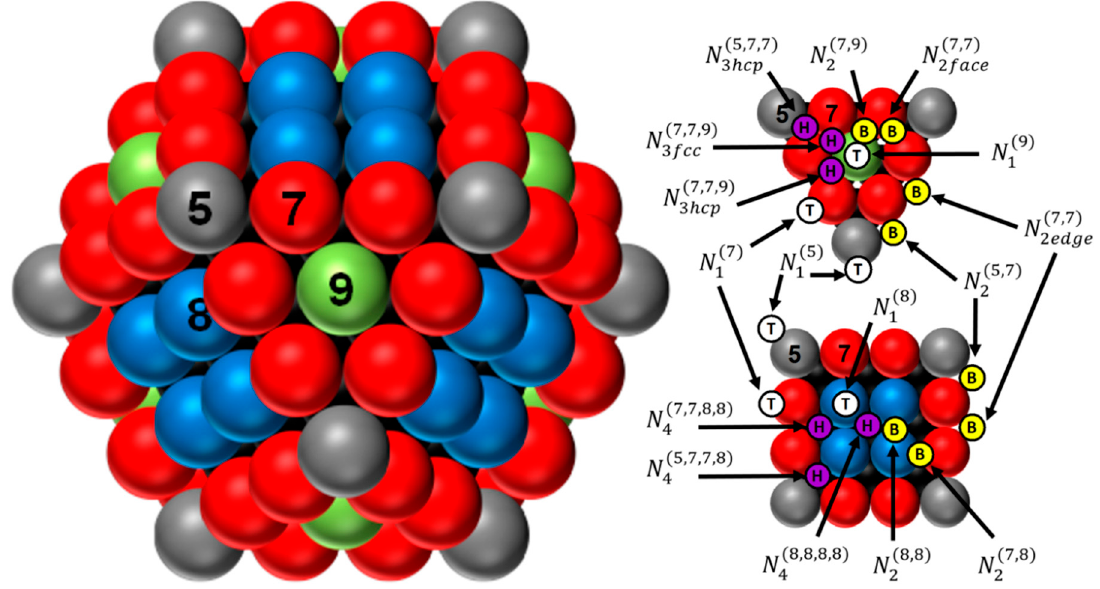
Figure 1. Representation of the perfect cuboctahedron (with m = 4) and its adsorption sites over triangular and square faces. The numbers 5 (grey), 7 (red), 8 (blue), and 9 (green) represent the coordination number of the atoms located in the corners, edges, faces (100), and faces (111), respectively. Top sites: white circle with a T ; bridge sites: yellow circle with a B; and hollow sites: purple circle with a H (for more details, see ref. [25]).